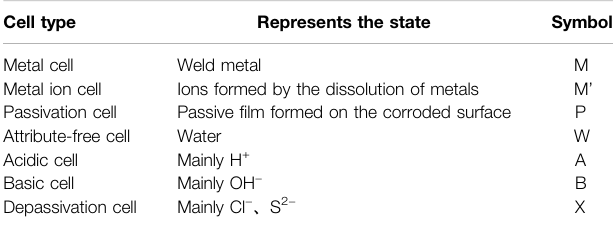
TABLE 3 | Cell types and states.